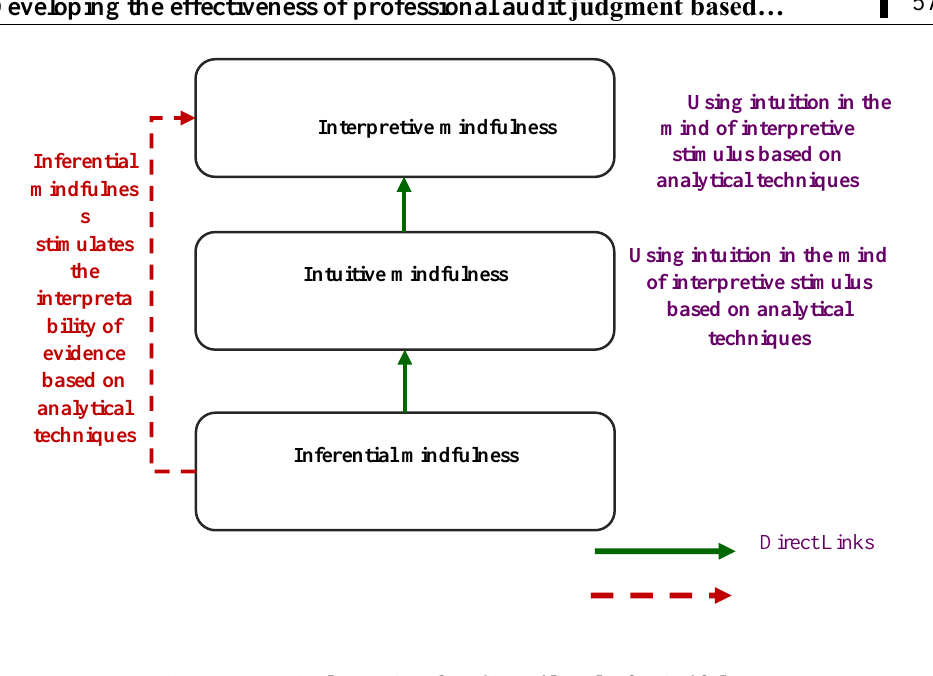
Figure 2. conical matrix of auditors' level of mindfulness Table 12. Selection of the most influential components of